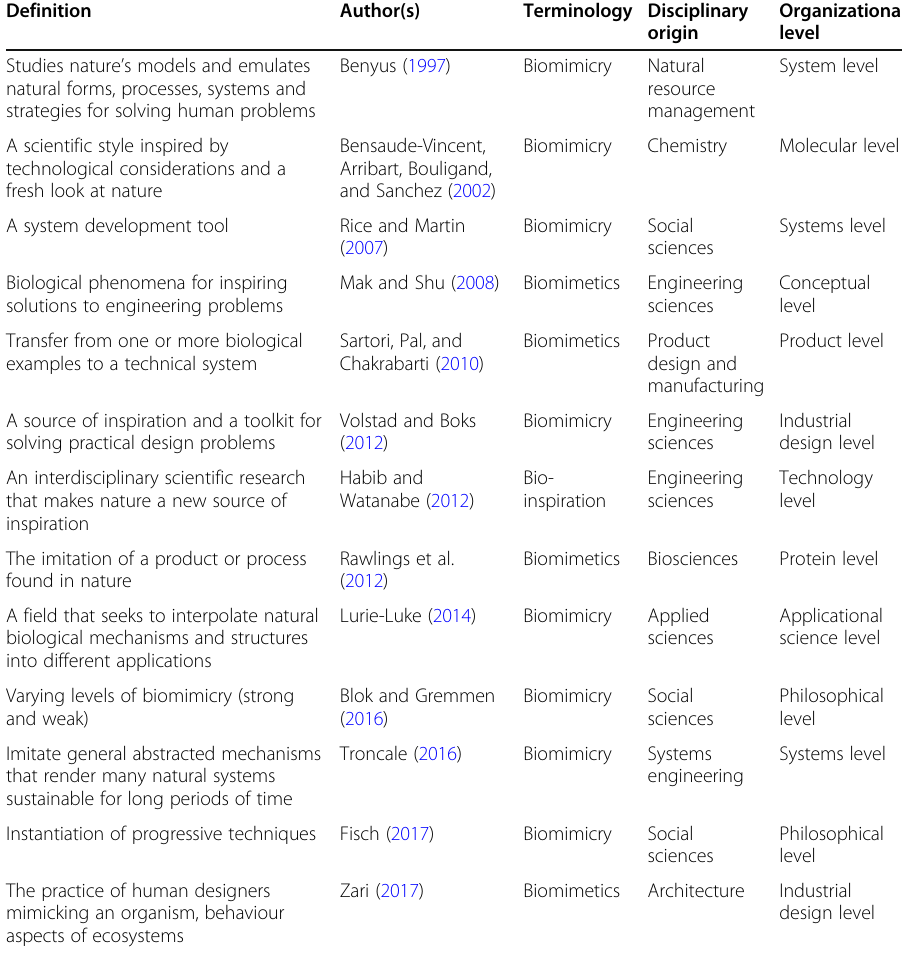
Table 1 Definitions, disciplinary origins and organizational levels in chronological order